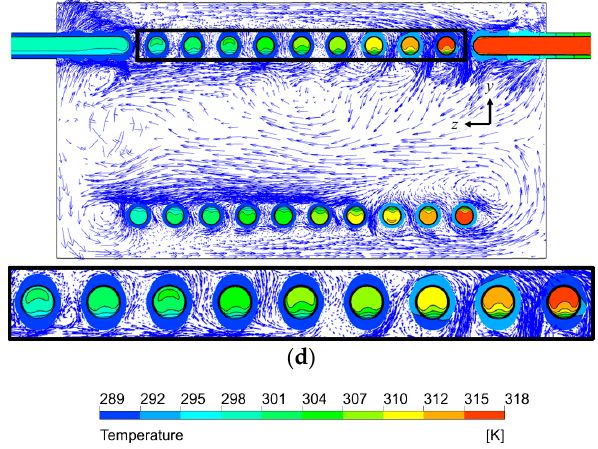
Figure 8. Temperature contours inside the helically-coiled tube with a velocity vector of the cold channel on the y–z plane at x = 0: ( a ) flat; ( b ) inline; ( c ) staggered; and ( d ) bulged. Energies 2016 , 9 , 1027